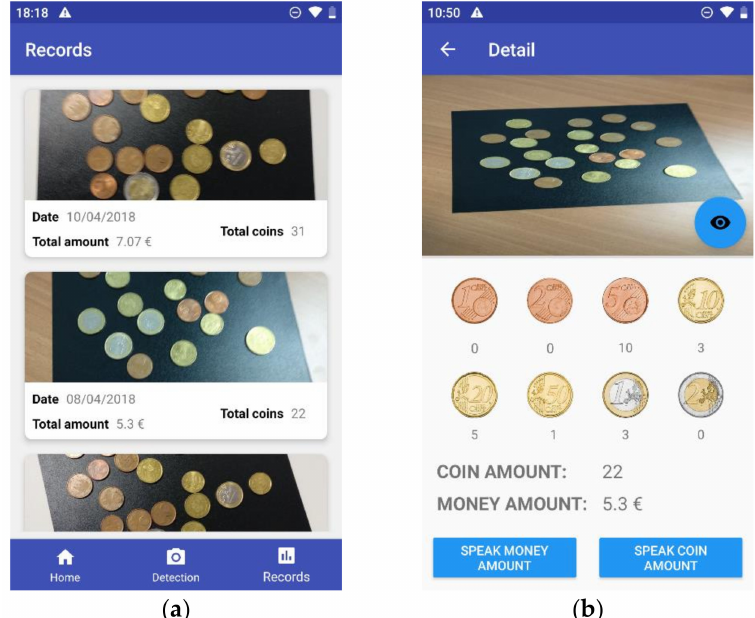
Figure 10. View of the application for the different tests performed. ( a ) List of performed tests; ( b ) Coin recognition result